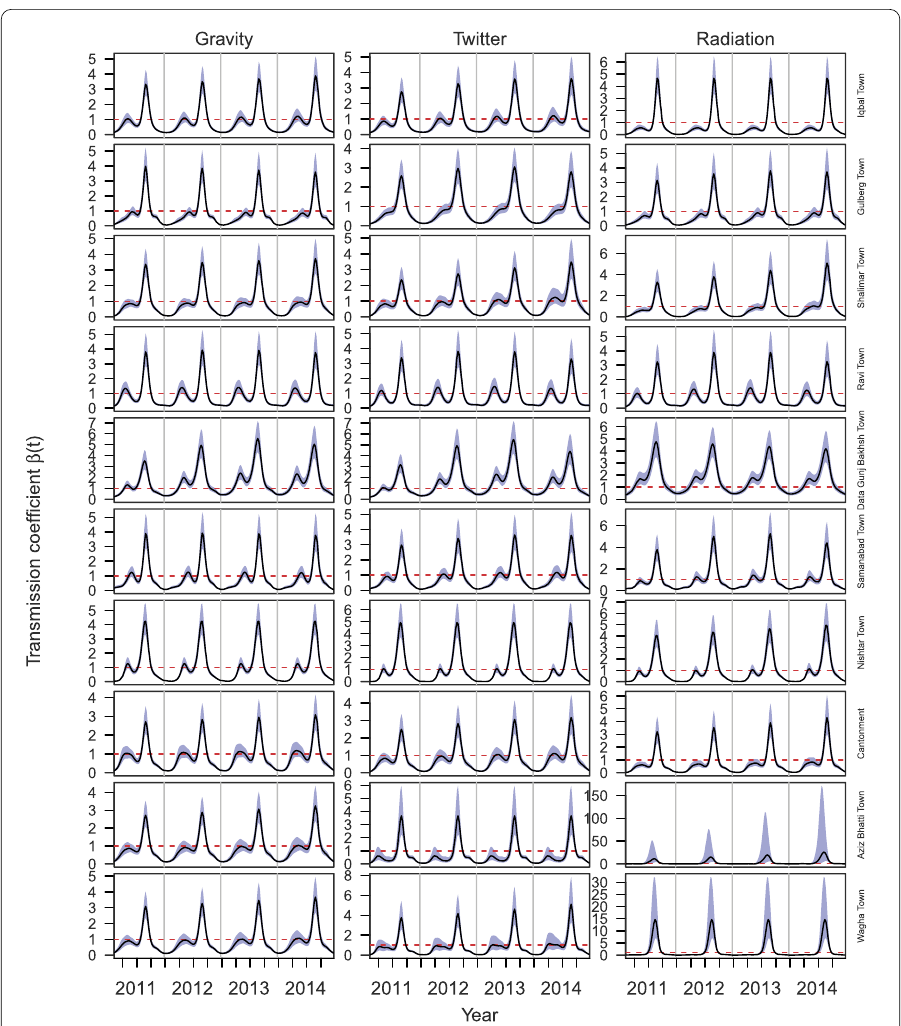
Figure 7 Temporal variation in β i ( t ) for different towns (rows) under three different mobility assumptions (columns): gravity model (left), Twitter (center), and radiation model (right). The black line shows the mean of the best-fit model and blue bands show standard error around the mean. The dashed red line indicates where